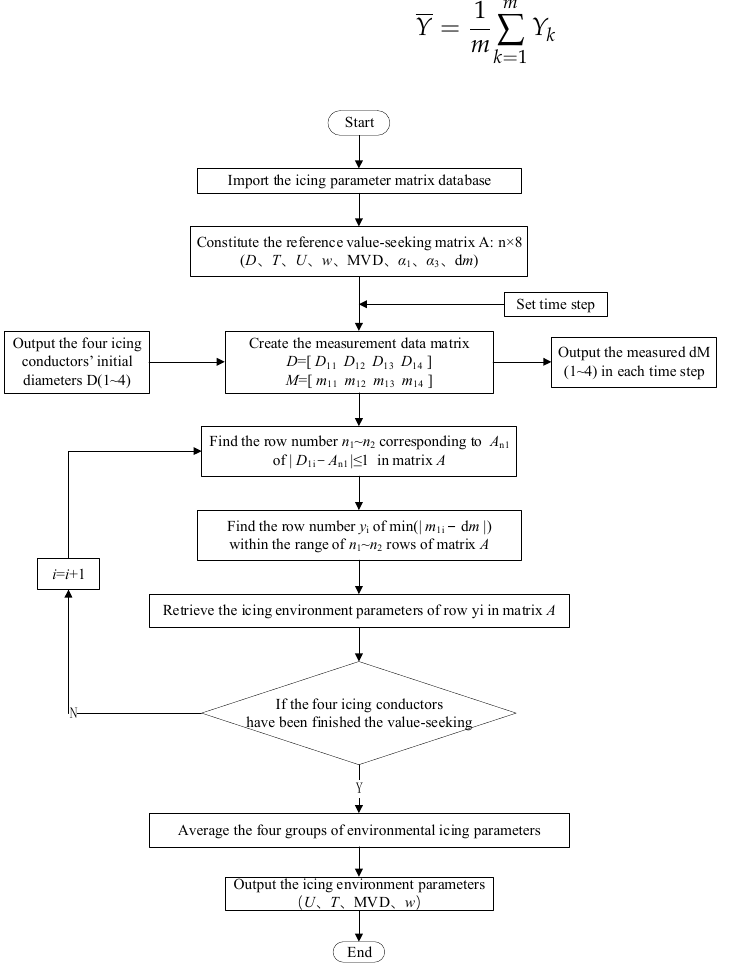
Figure 5. The icing environment parameters value seeking calculation process (when the number of cylinders is 4).